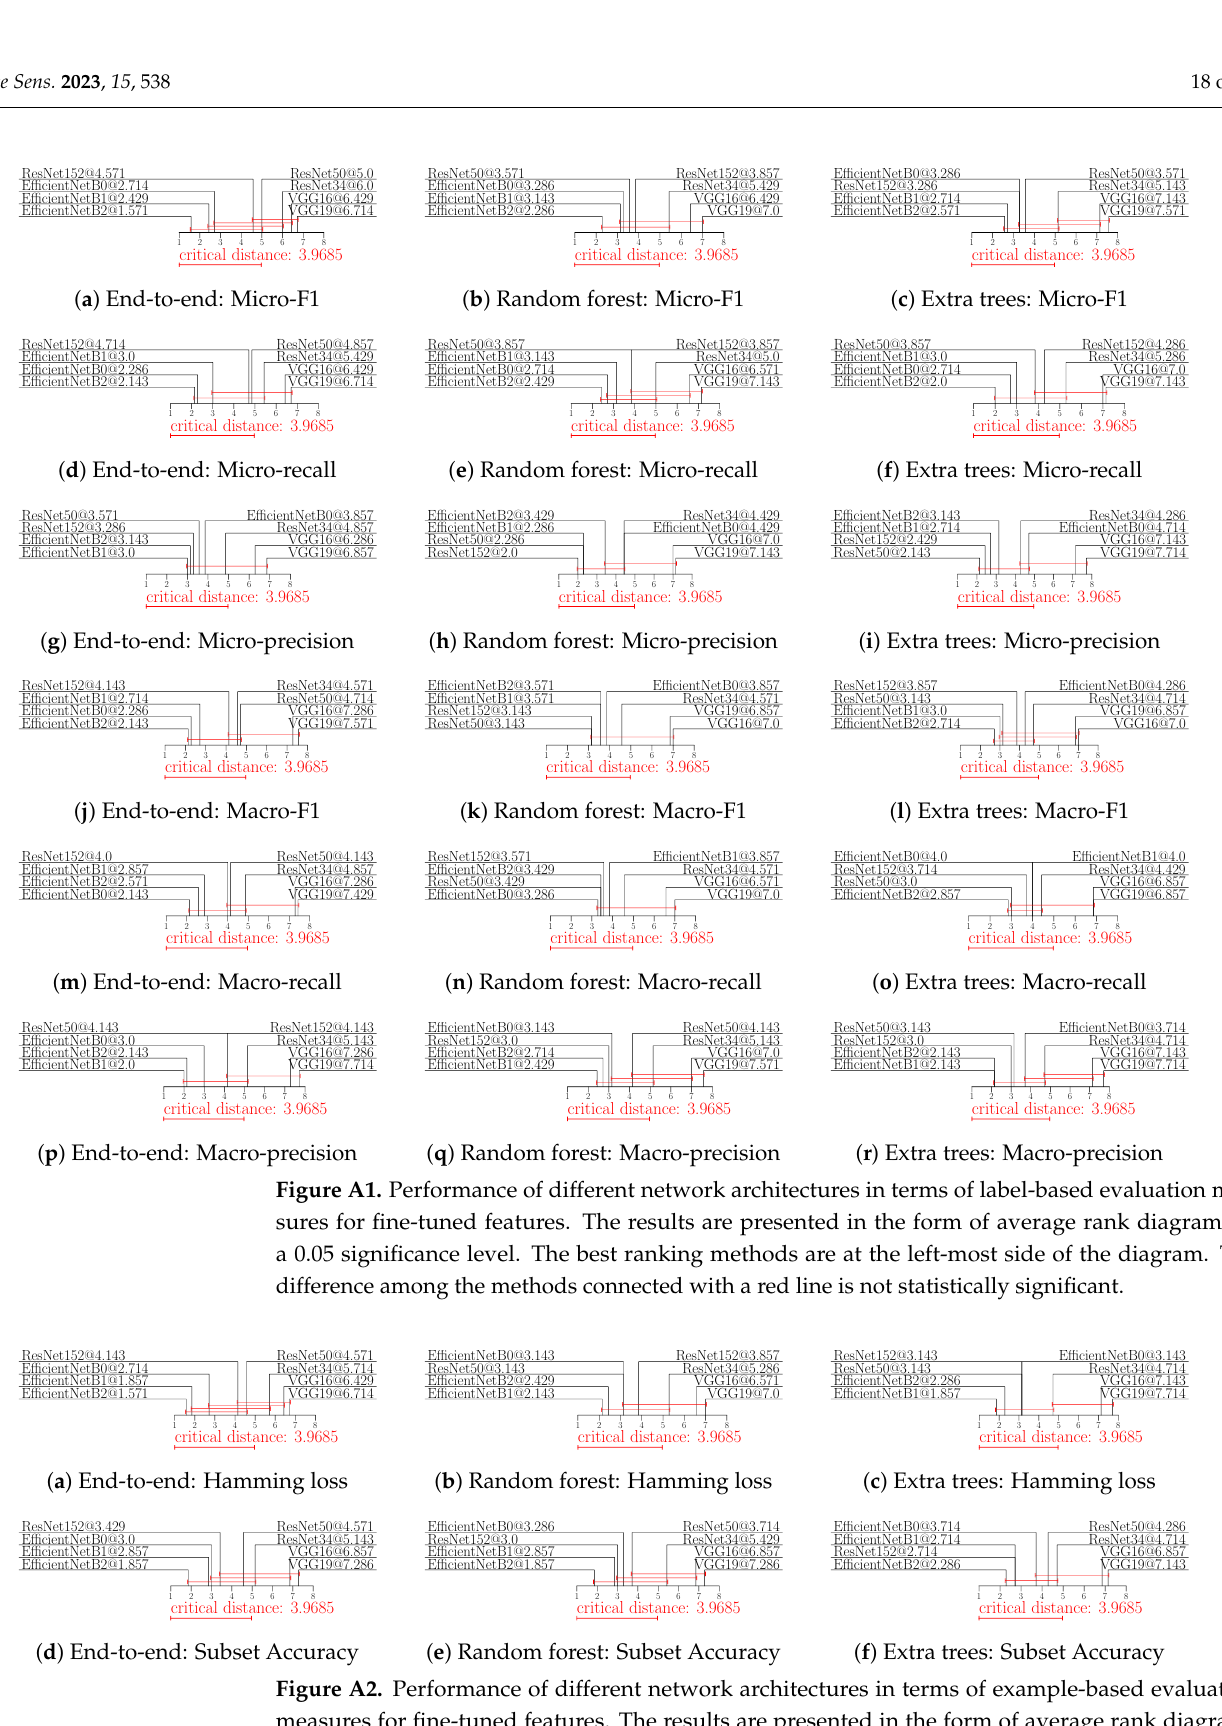
Figure A2. Performance of different network architectures in terms of example-based evaluation measures for fine-tuned features. The results are presented in the form of average rank diagrams at a 0.05 significance level. The best ranking methods are at the left-most side of the diagram. The difference among the methods connected with a red line is not statistically